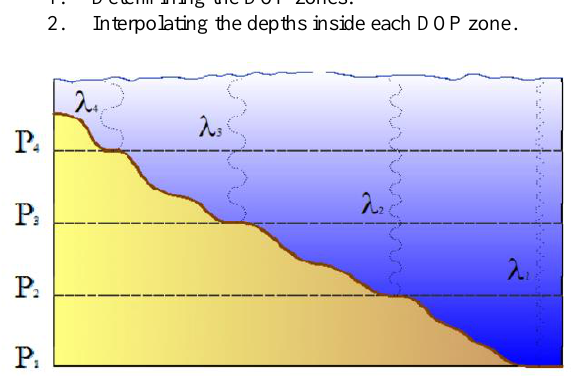
Figure 1. Penetration of light in water depending on wavelength.